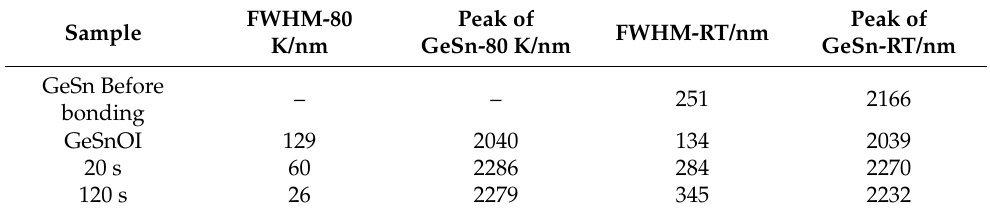
Table 4. PL data for the GeSn peak at 80 K and at room temperature (RT) after Ge vertical wet etching.